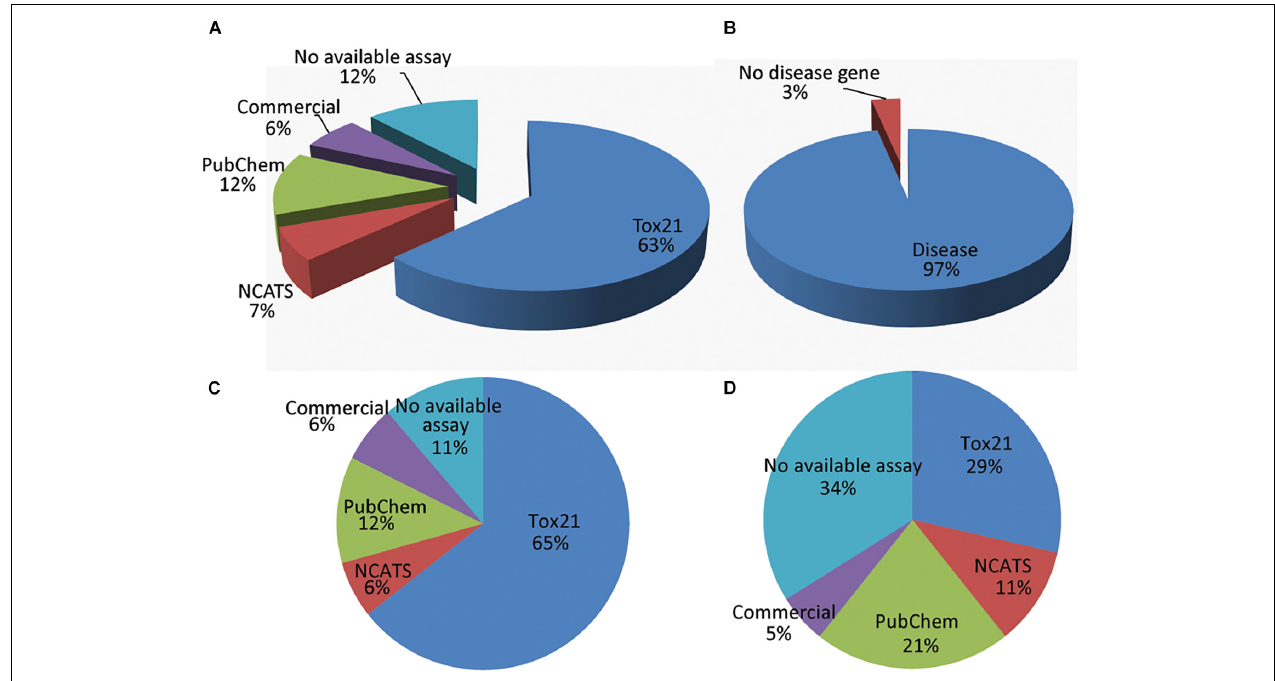
FIGURE 3 | Disease pathways and assay availability from four sources (in the order of decreasing priority): (1) Tox21, (2) NCATS, (3) PubChem, and (4) commercial vendors. If a pathway was covered by assays from multiple sources, only the source with the highest priority was counted. (A) Assay availability for all pathways. (B) Fraction of pathways that are disease pathways. (C) Assay availability for disease pathways. (D) Assay availability for non-disease